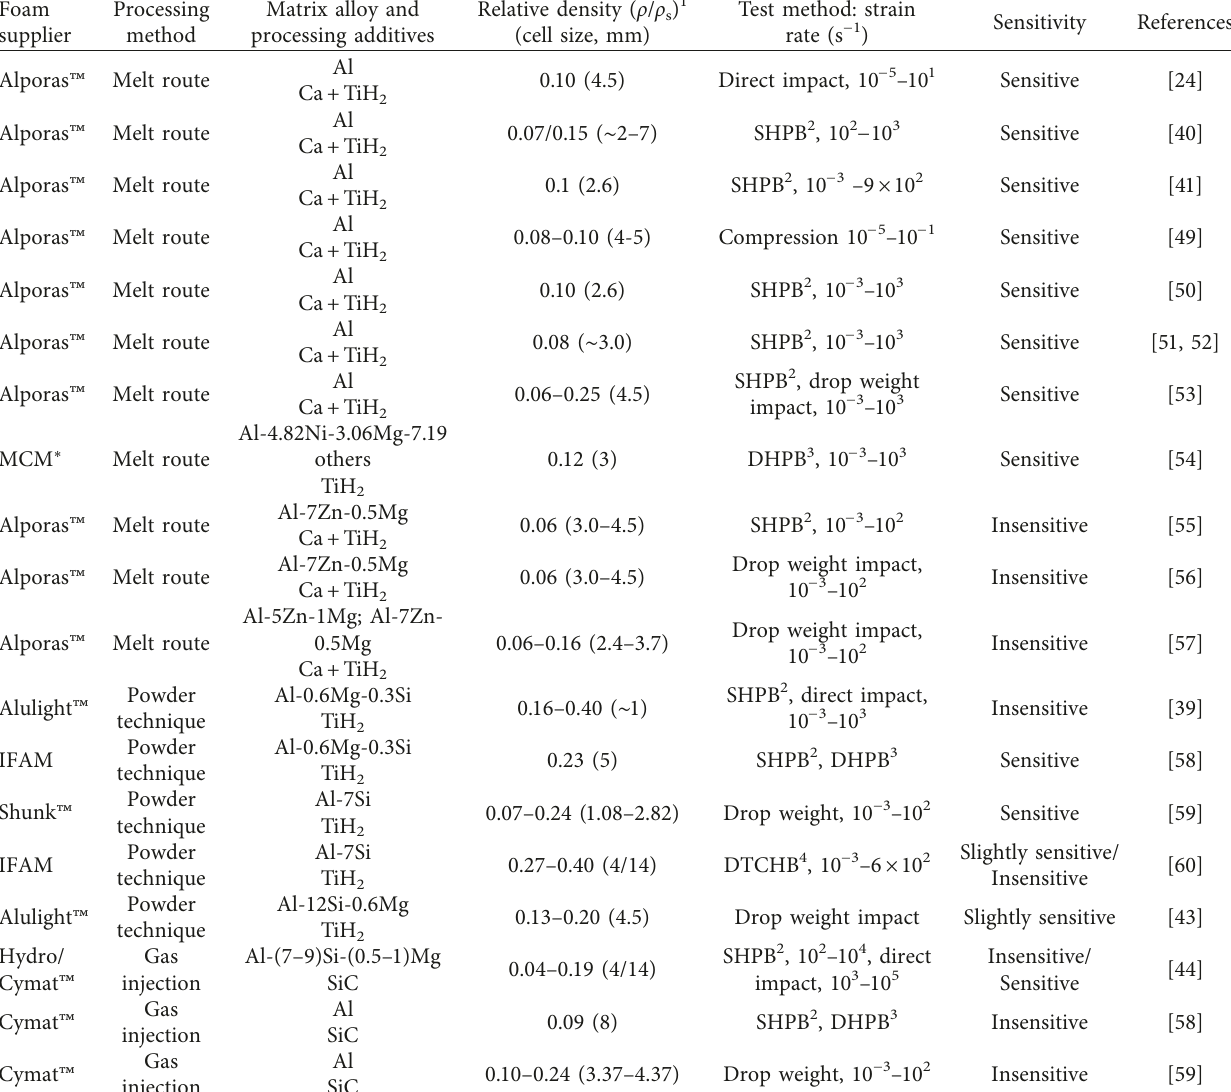
Table 1: Strain rate sensitivity of closed-cell Al